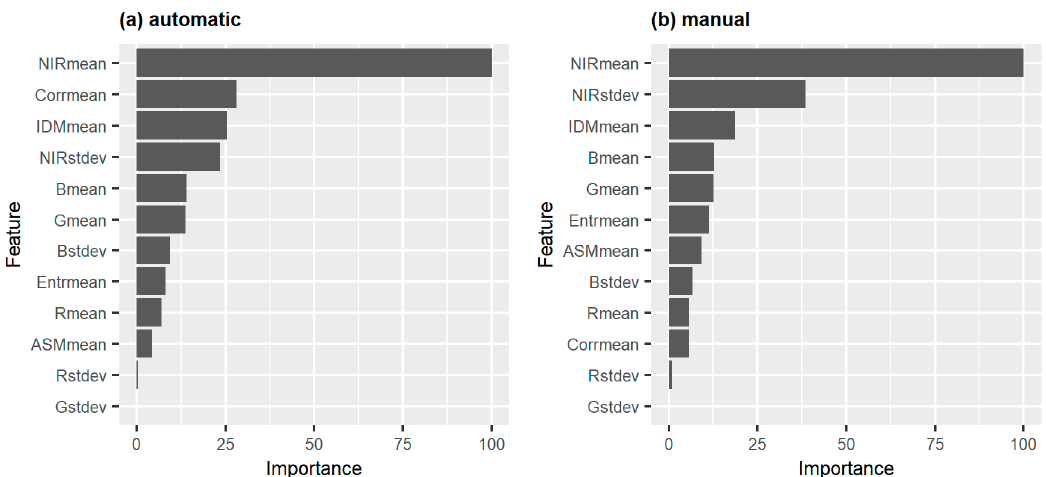
Figure 7. Variable importance in Random Forest training with training data derived by ( a ) automatic; ( b ) manual selection processes for models trained on all variables (RGB + nIR + Texture). Table 2. Classification accuracies and kappa coe ffi cient using di ff erent input variables and training